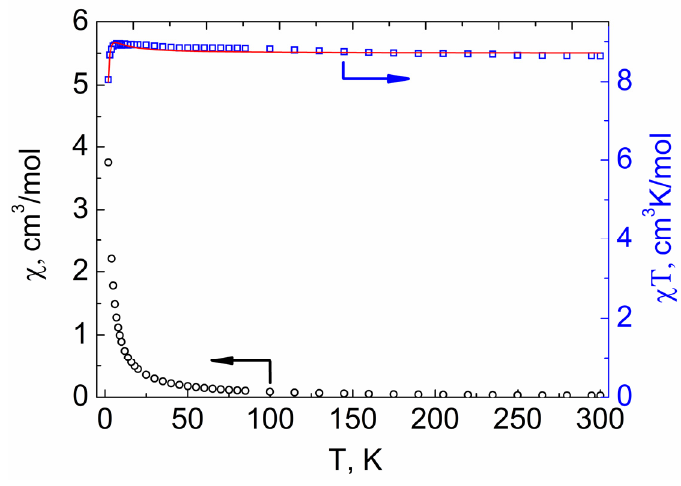
Figure 11. Temperature dependencies of the χ M T product ( □ ) and χ M ( ○ ) for compound 1 . The red line shows the values calculated using PHI [48] program.